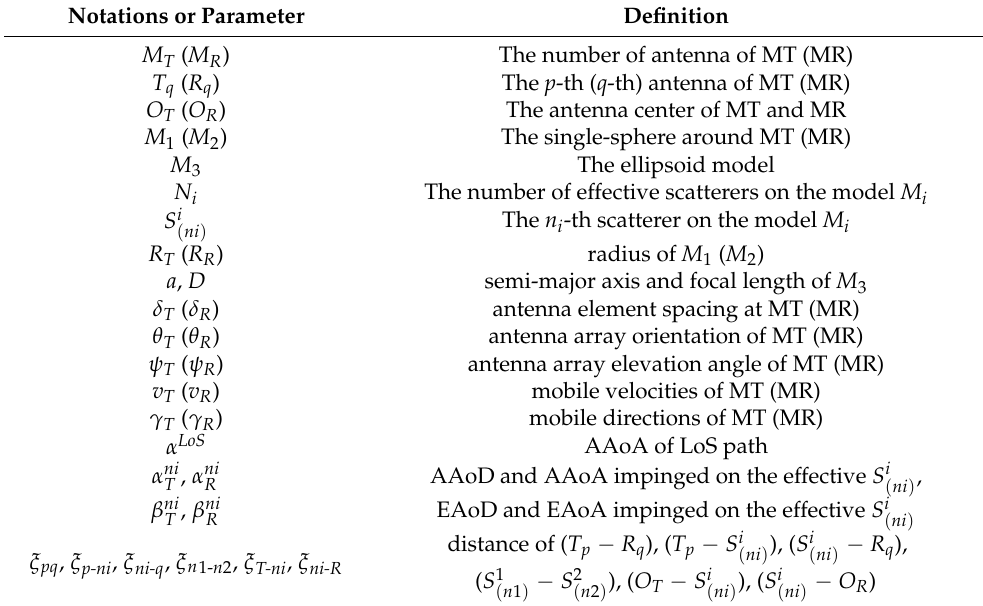
Table 1. The definition of notations and parameters in proposed model.